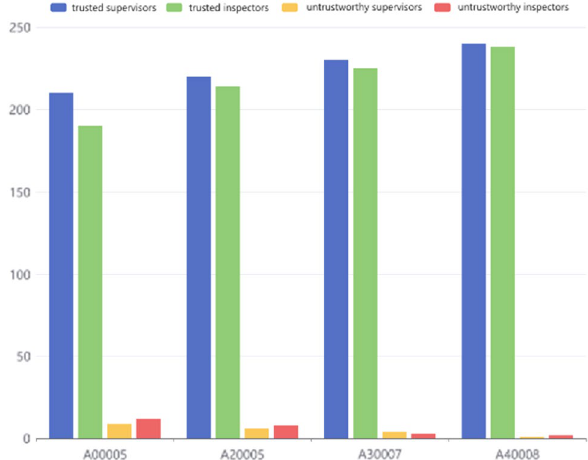
Figure 13. Analysis of dynamic supervision and inspection